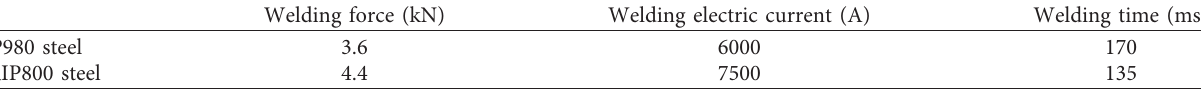
Table 1: Welding parameters.